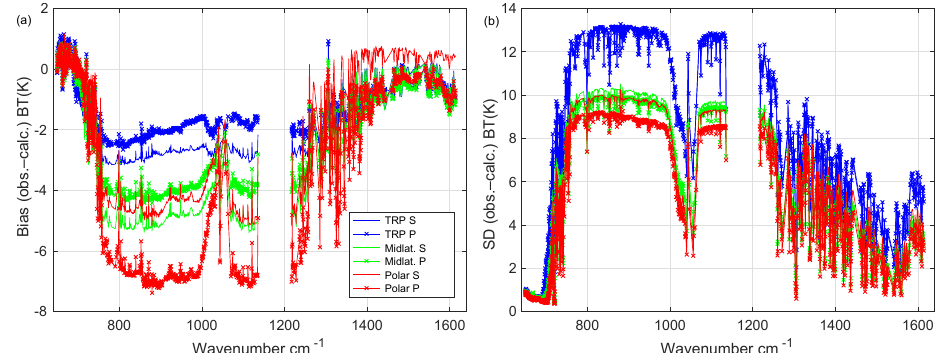
Figure 8. Mean biases (a) and standard deviations (b) between observations and calculations for ocean night scenes on 11 March 2011 for tropical (TRP), midlatitude (Midlat.) and polar (Polar) regions. Curves with × symbols are for PCRTM–MRO (PMRO). Solid lines denote SARTA–TwoSlab. Results are similar in the tropics and midlatitudes, with larger differences at the poles. See Fig. 7 for the corresponding BT1231 PDF